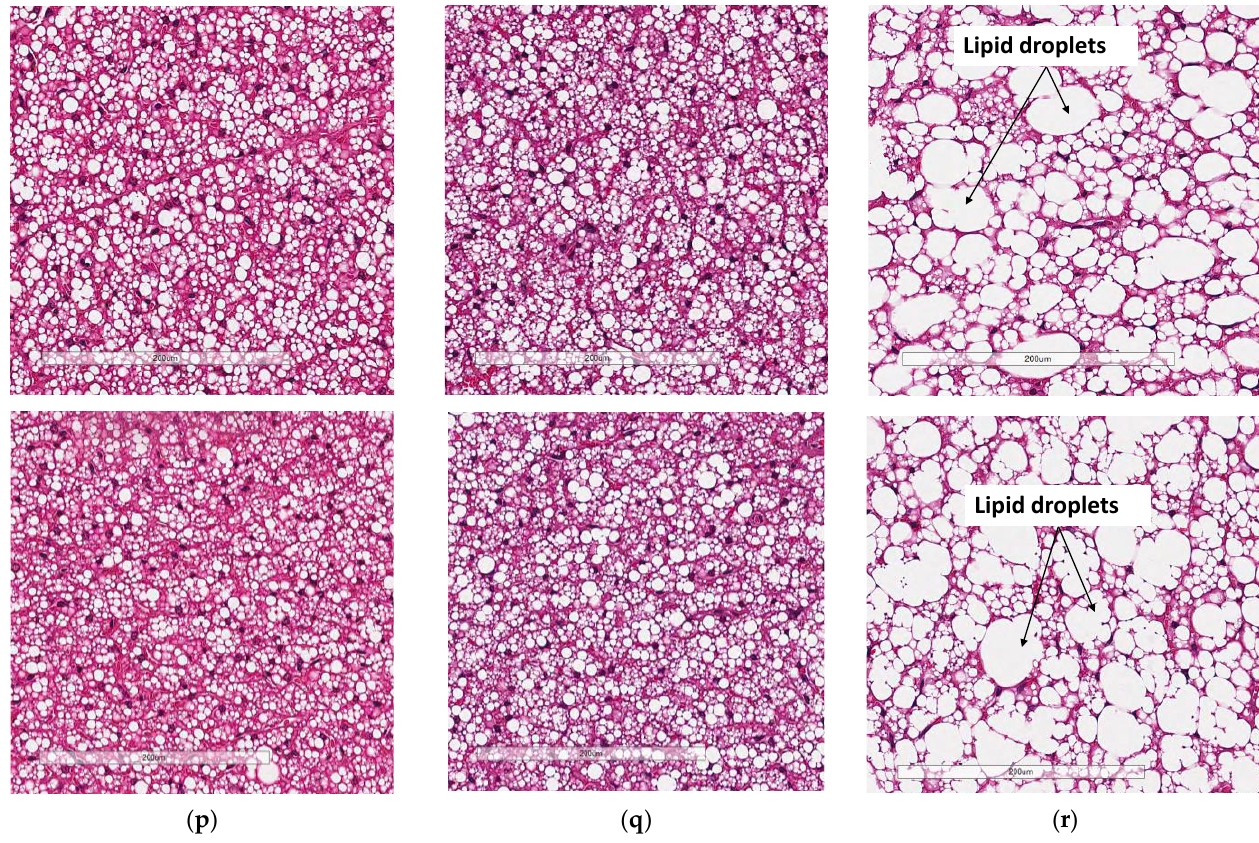
Figure 4. Adipocyte size distribution across the various adipose tissue depots. H&E-stained sections of perigonadal WAT (pWAT) ( d ) revealed that the WTHFD ( c ) had significantly larger ( p < 0.001) adipocytes than WTCD ( a ) and KOHFD ( b ). The number of adipocytes per field was significantly lower in WTHFD than KOHFD ( p < 0.05) and WTCD ( p < 0.001), ( e ). Similarly, the adipocyte diameter in the inguinal subcutaneous WAT (iWAT) of WTHFD ( h ) was significantly greater ( p < 0.001), ( i ), than that of WTCD ( f ) and KOHFD ( g ). Conversely, the number of adipocytes per view was significantly lower ( p < 0.001) in WTHFD than in WTCD and KOHFD, ( j ). Significantly more ( p < 0.001) adipocyte hypertrophy ( n ) was also observed in the mWAT of WTHFD, ( m ), than in WTCD, ( k ) and KOHFD ( l ). Additionally, significantly ( p < 0.01) fewer adipocytes were viewed per field in WTHFD than in WTCD and KOHFD ( o ). Sections of the BAT revealed that WTCD ( p ) and KOHFD ( q ) had smaller lipid droplets compared with those observed in WTHFD ( r ). Magnification = 20× Scale bar = 200 µm. Key: A = adipocyte. N = 120 adipocytes. * p < 0.05, ** p < 0.01, *** p < 0.001.